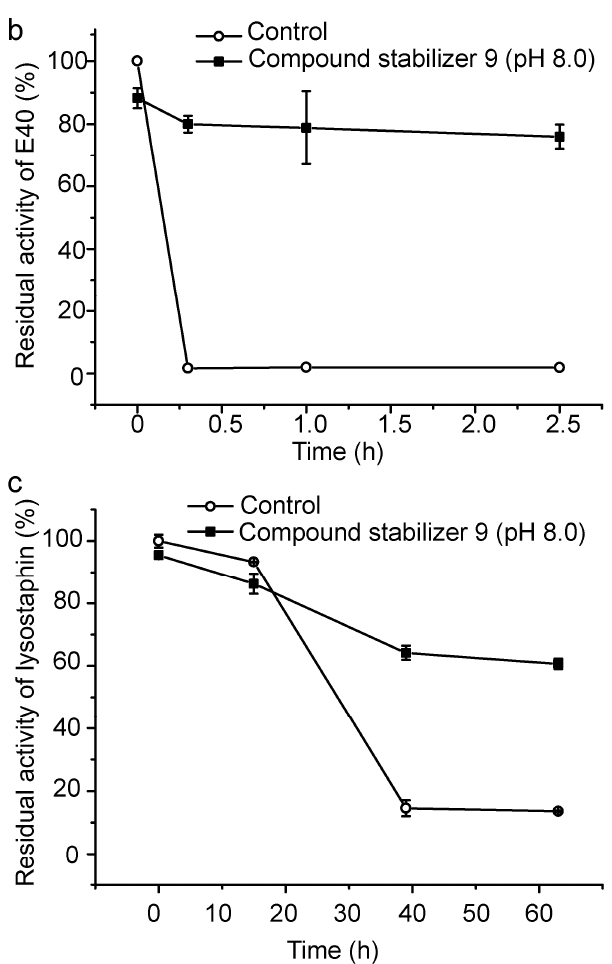
Figure 7. Effect of compound stabilizer 9 on the thermostability of myroilysin ( a ); E40 ( b ); and lysostaphin ( c ). Each enzyme mixed with compound stabilizer 9 was incubated at 37 °C. The activity of the enzyme solution in 50 mM Tris-HCl (pH 9.0) before incubation at 37 °C was taken as 100%. Experiments were performed in triplicate, and error bars indicate standard deviation.